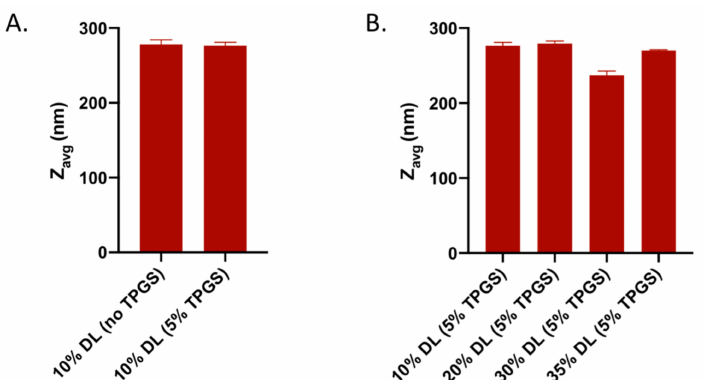
Figure 9. Z-average (Z avg ) particle diameter for amorphous nanoparticles generated upon dissolution: without and with TPGS (5%) at 10% DL ( A ) and at different DLs with 5% TPGS level ( B ).